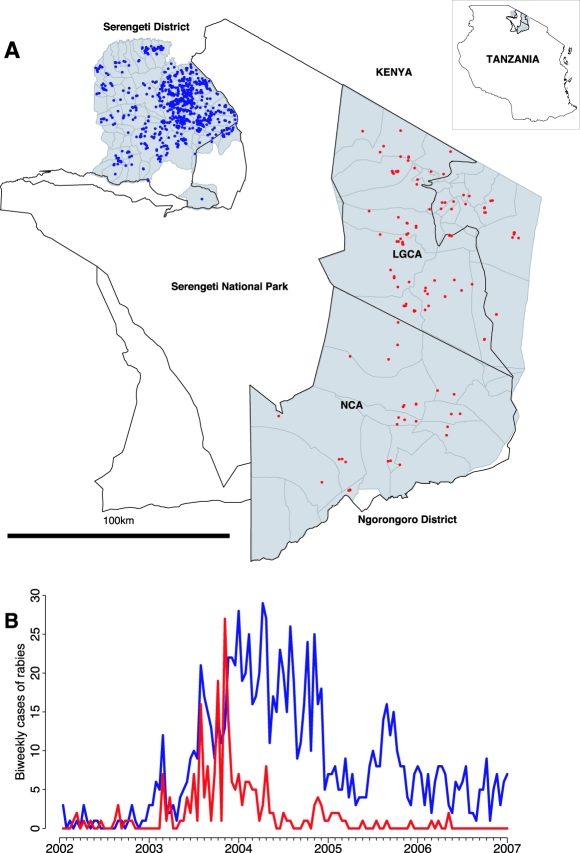
The Location and Timing of Animal Rabies Cases in Serengeti and Ngorongoro Districts, Northwest Tanzania(A) Rabies cases in Serengeti (blue) and Ngorongoro (red) districts from January 2002 until December 2006. LGCA = Loliondo Game Controlled Area, NCA = Ngorongoro Conservation Area. Dark gray lines show village boundaries. Populations of humans and domestic dogs are denser in Serengeti district than Ngorongoro (Table 3).(B) Biweekly time series of rabies cases in each district.